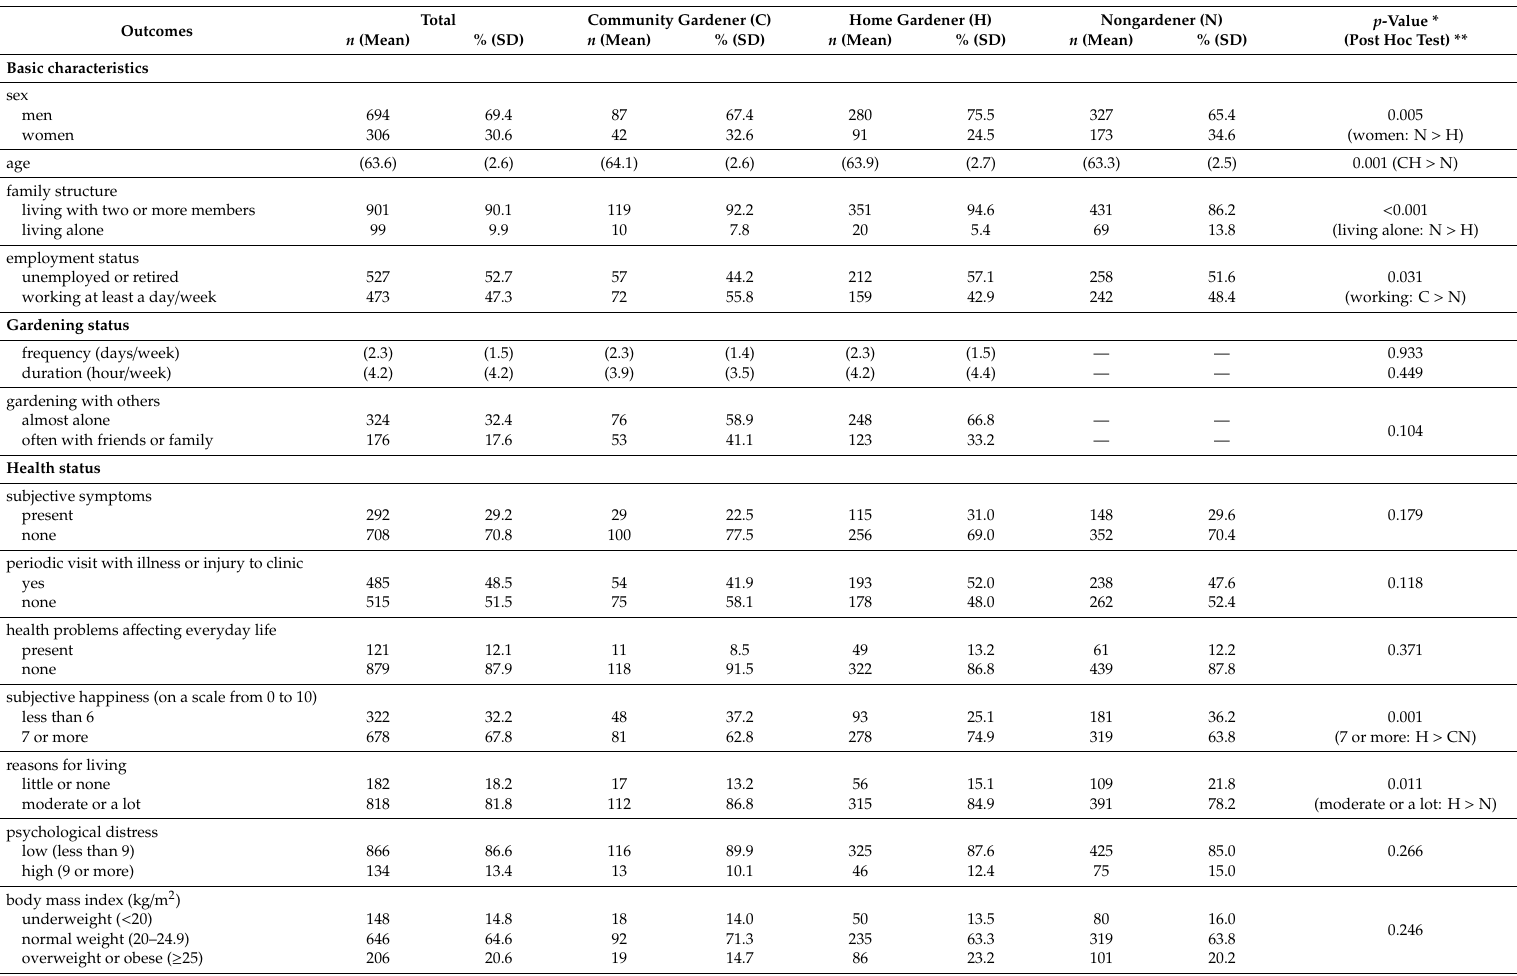
Table 1. Distribution of